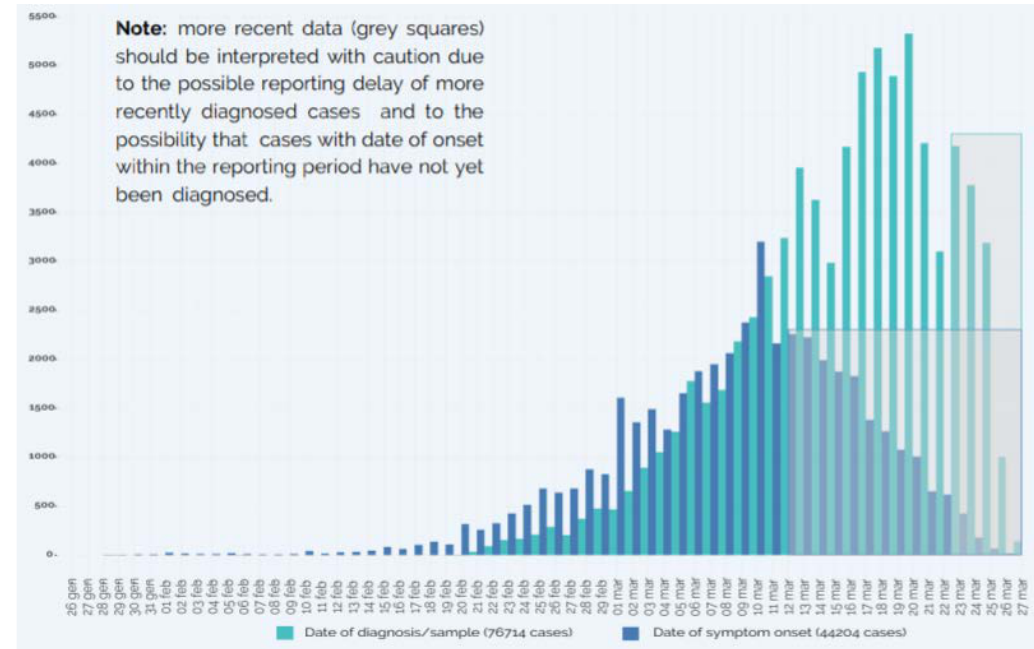
Figure 1. Number of COVID-19 cases by date of diagnosis/sample ( N = 76,714) and number of COVID- 19 cases by date of symptom onset ( N = 44,204)—27 March 2020 [15]. COVID-19 cases by date of symptom onset ( N = 44,204)—27 March 2020